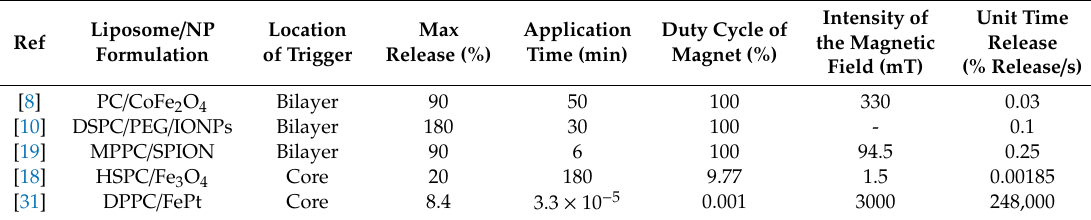
Table 1. Comparison normalized e ffi ciencies of magneto liposomal drug delivery systems from literature. The data show that pulsed magnetic field induced drug release is more e ff ective than other techniques when the unit time release is